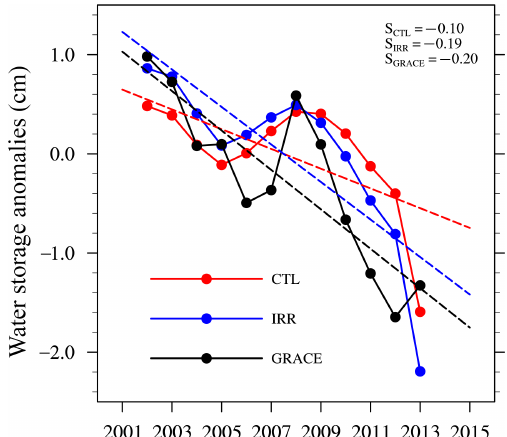
Figure 4. Basin-averaged terrestrial water storage (TWS) from GRACE and the modeled TWS from CTL and IRR in the period of